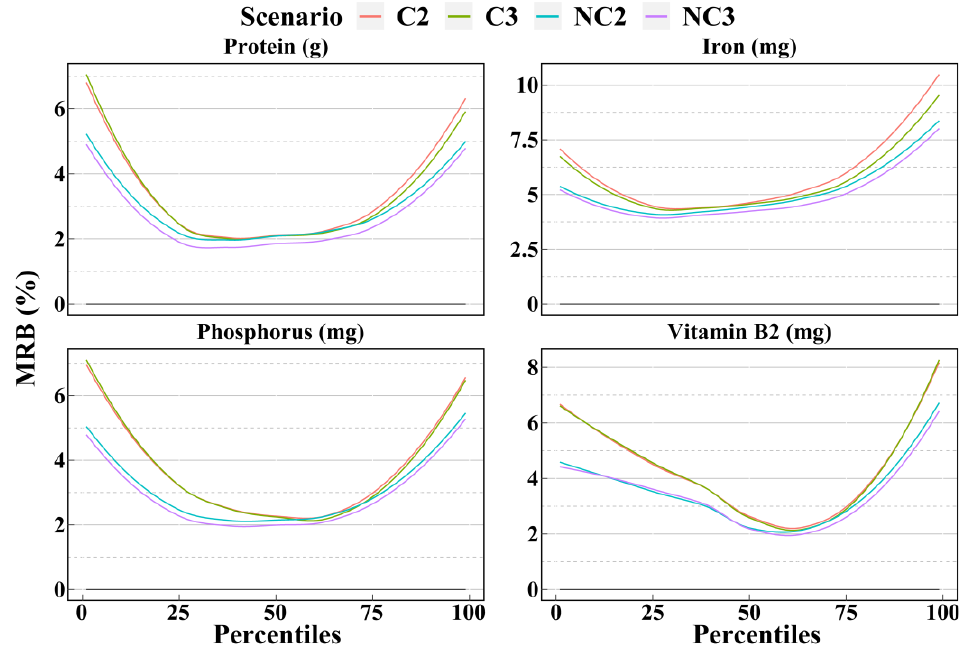
Figure 3. Smooth curves of the percentile (from 1st to 99th) intakes of dietary components in group 1 as calculated by the NCI method based on the 4 scenarios. Smooth curves of bias and relative bias for 12 dietary components calculated for the 4 scenarios are available in Supplementary Figure S2. C2 = 2 consecutive days; C3 = 3 consecutive days; NC2 = 2 non-consecutive days; NC3 = 3 non-consecutive days; MRB = Mean relative bias.